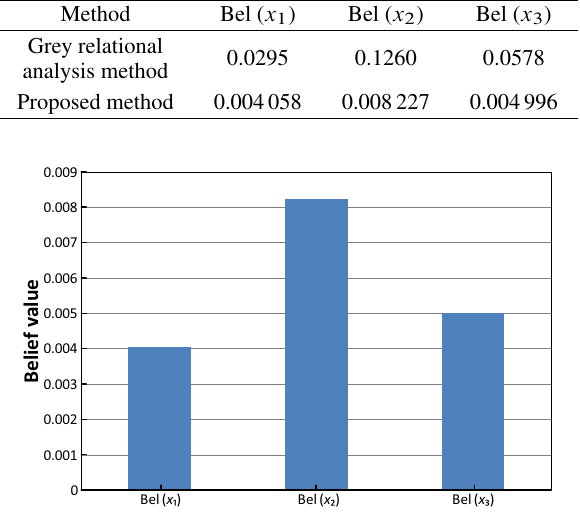
Table 9 Alternatives’ belief measures in two unlike ways.